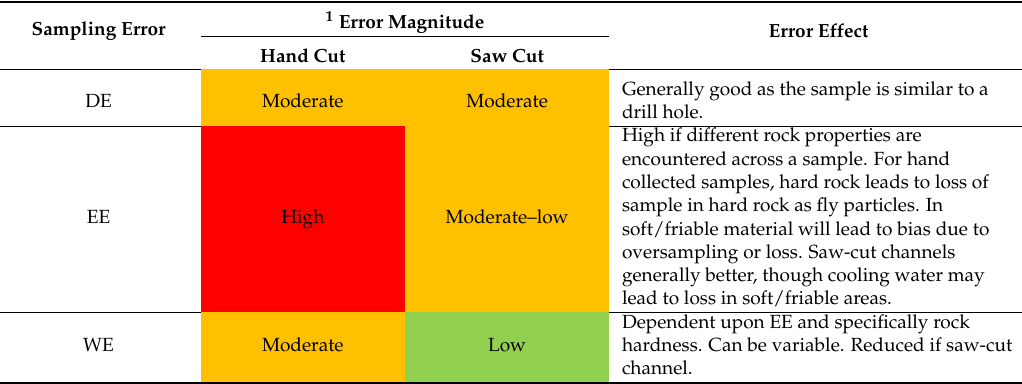
Table 10. Likely sampling errors during the collection of channel samples.